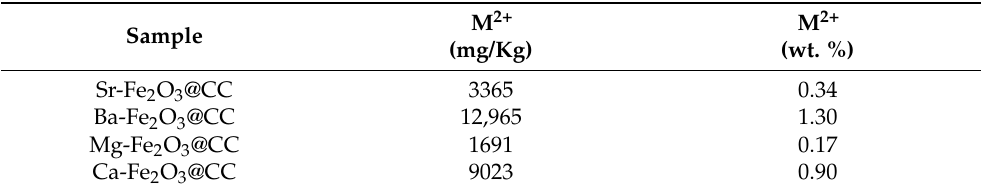
Table 1. The content of Sr 2+ , Ba 2+ , Mg 2+ , and Ca 2+ in Sr-Fe 2 O 3 @CC, Ba-Fe 2 O 3 @CC, Mg-Fe 2 O 3 @CC, and Ca-Fe 2 O 3 @CC according to the ICP-OES measurement.